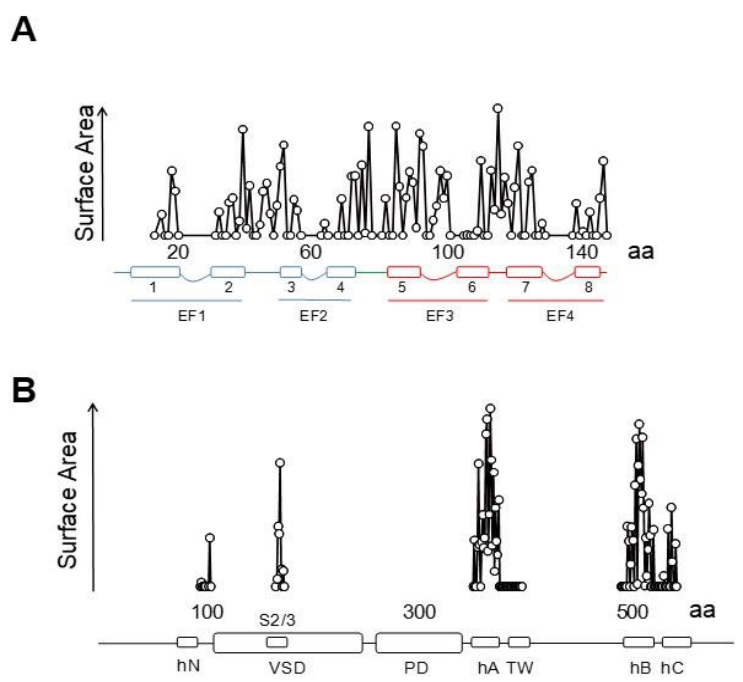
Figure 16. Hypothetical PIP 2 binding site influenced by CaM EF3. The pore residues (GYG) were used as a reference to align the Kir structure (PDB 3SYA) to KCNQ1 (5VMS). The PIP 2 molecule was manually moved maintaining the distance from the membrane to the presumed docking site, and manually adjusted to avoid obvious clashes. The docking space is delimited by pre-S1, S2 / 3 and S4 / 5 linkers. The positively charged Arg and Lys residues in KCNQ1 are represented as sticks using the CPK coloring scheme, as well as CaM Asn 98 and Tyr